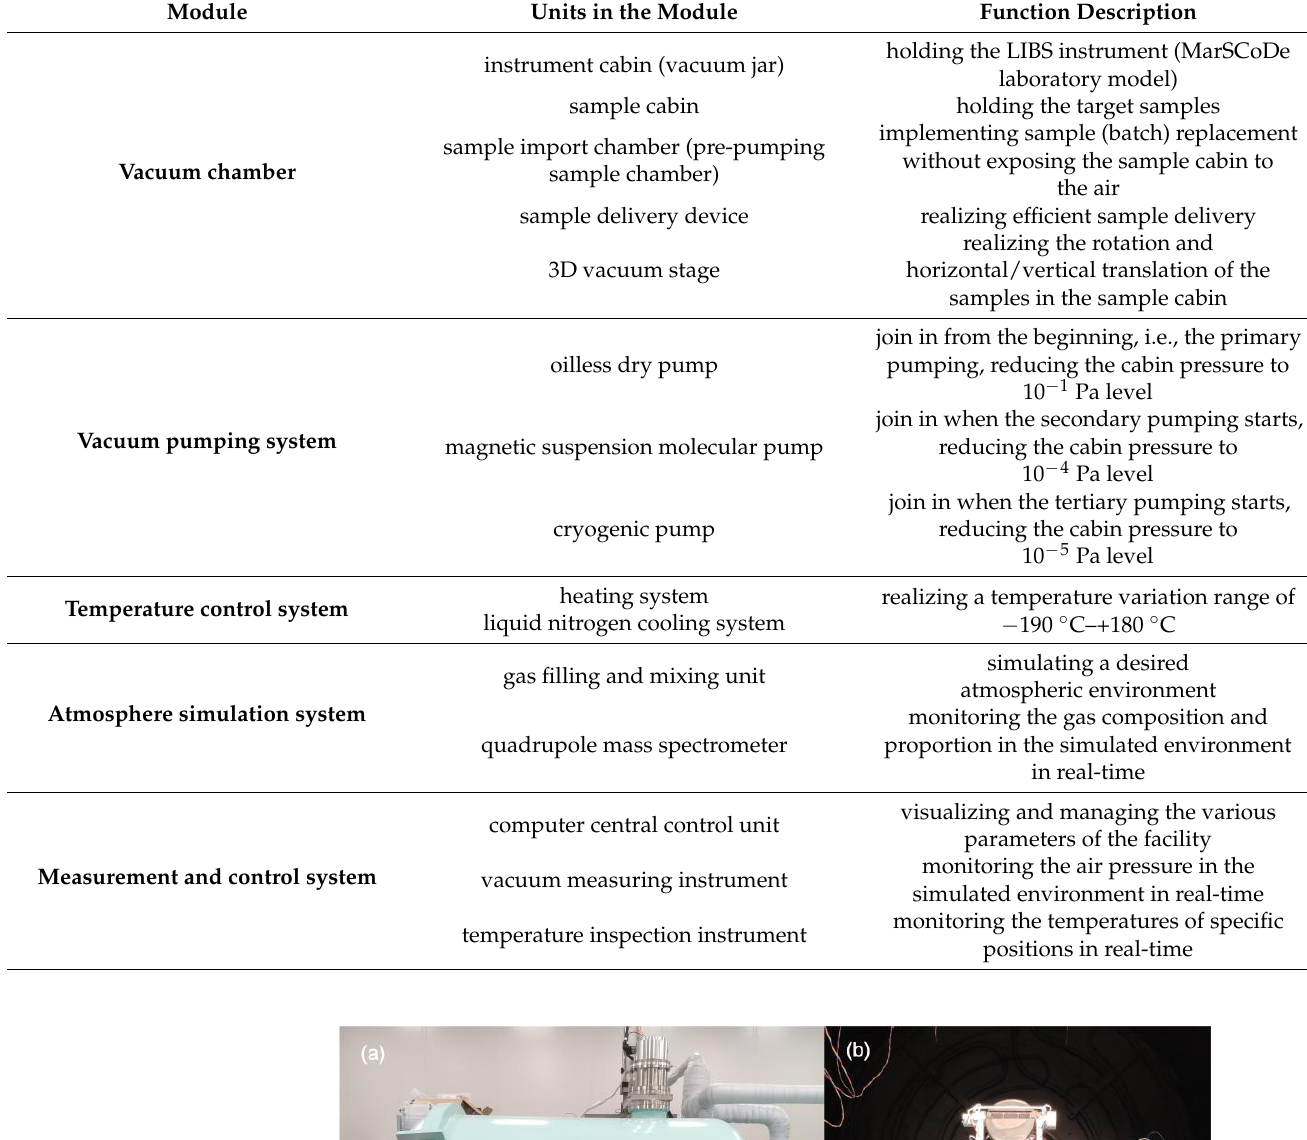
Table 2. The modules and included units of the facility and their corresponding functions.